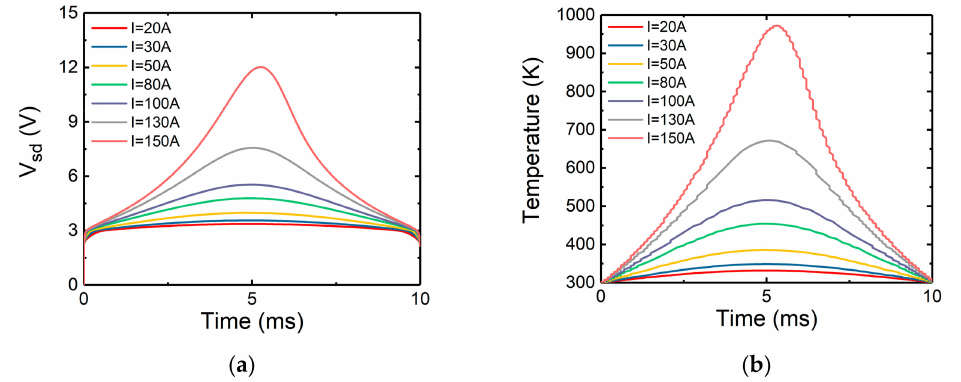
Figure 15. When the channel is non-conducting, the simulated ( a ) source-drain voltage, ( b ) maximum temperature, with time.